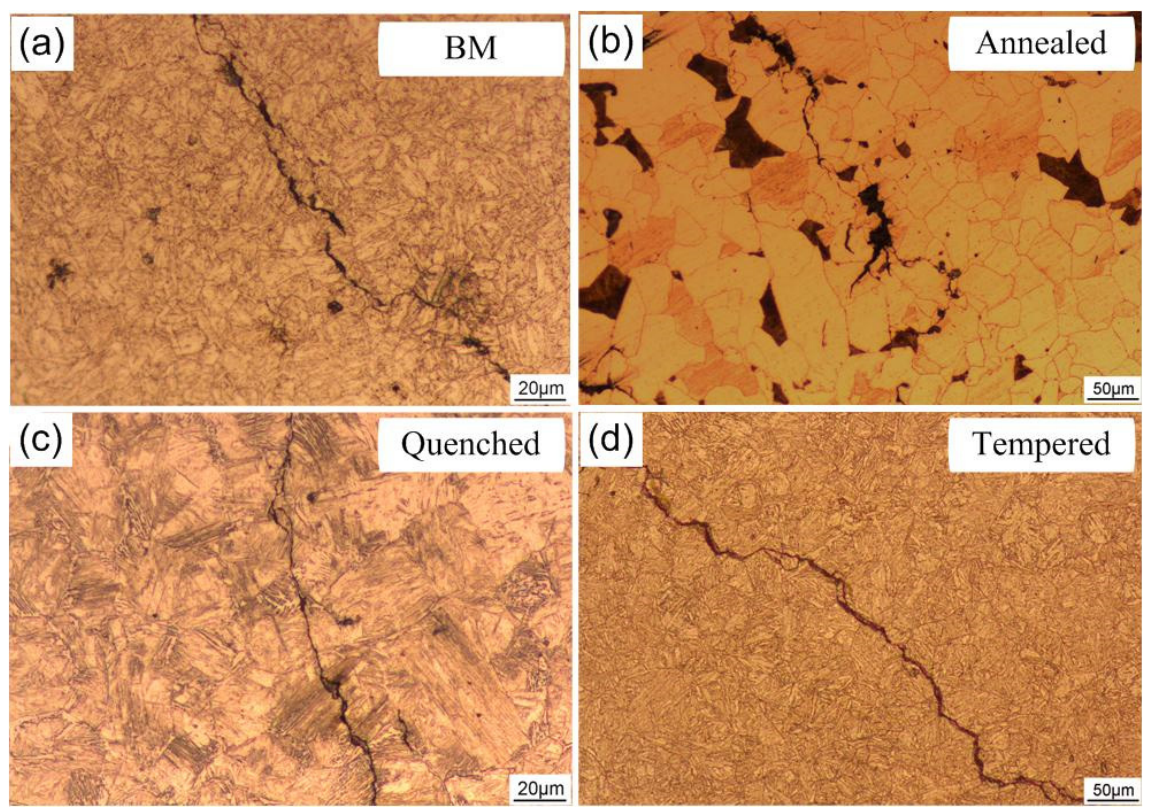
Figure 13. Light microscope micrographs of the hydrogen-induced cracks formed on the steel base metal ( a ), annealed steel ( b ), quenched steel ( c ), tempered steel ( d ).